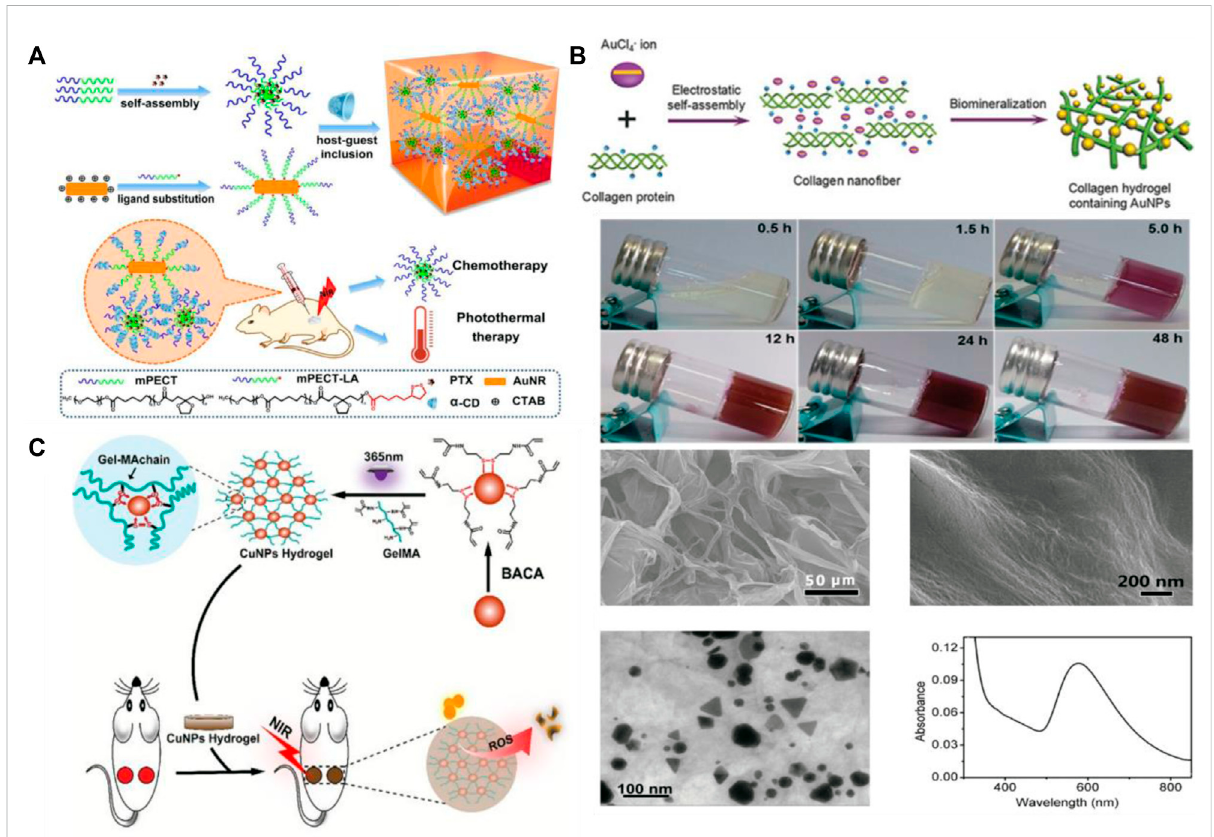
FIGURE 1 (A) Preparation of gold nano hydrogel and its application in chemotherapy-assisted photothermal therapy. Reproduced from ref.49 with permission from 2019 Royal Society of Chemistry. (B) Synthesis and characterization of injectable and self-healing collagen hydrogels containing gold nanoparticles. Reproduced from ref. 87 with permission from 2016 WILEY-VCH. (C) Preparation of copper nano hydrogel and schematic diagram of antibacterial principle of photothermal therapy. Reproduced from ref. 75 with permission from 2019 Royal Society of